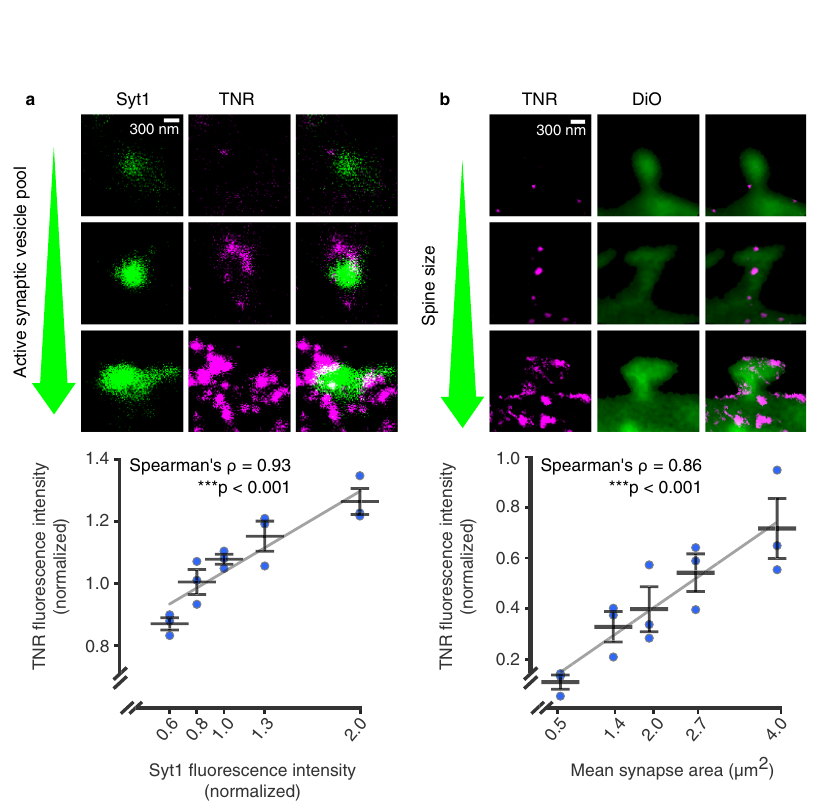
Fig. 2 Dynamic TNR molecules emerge at synapses, in an activity-dependent fashion. a To monitor dynamic TNR molecules, surface epitopes were blocked by incubating with non- fl uorescent TNR antibodies (gray). After some time, fl uorophore-conjugated antibodies were applied (red) to reveal newly- emerged epitopes (dark blue). b Newly-emerged epitopes 2/4/12 h post-blocking, (epi fl uorescence). Scale bar = 10 µ m. c Fluorescence intensity, normalized to non-blocked neurons. N = 3 independent experiments, ≥ 10 neurons per datapoint. Repeated-measures one-way ANOVA: F 1.089,2.179 = 790.8, *** p < 0.001, followed by Fisher ’ s LSD: ‘ 2 h ’ / ‘ 4 h ’ : *p = 0.041; ‘ 4 h ’ / ‘ 12 h ’ : *p = 0.032; ’ 12 h ’ / ‘ no blocking ’ : ** p = 0.002. d All TNR epitopes (left) or newly-emerged epitopes 12 h post-blocking (right) were revealed (magenta, STED imaging). Membranes of a subset of neurons were labeled using sparse DiO labeling (green, confocal imaging). Presynapses were identi fi ed by VGlut1 (blue, STED imaging). Scale bars: 1 µ m (full images), 500 nm (insets). Bottom: hundreds of synapses were averaged by centering synapse images on the VGlut1 puncta and orienting the dendritic DiO signals vertically. “ All ” TNR epitopes cover the entire bouton-dendrite area (left), while newly-emerged epitopes are enriched in the bouton region (right). e Quanti fi cation of TNR exchange at synapses (as in c , measuring exclusively TNR at VGlut1-labeled synapses). N = 3 independent experiments with >100 synapses. f Comparison of newly-emerged TNR epitopes 12 h post-blocking in cultures treated with bicuculline (40 µ M), or CNQX (10 µ M) and AP5 (50 µ M). Intensity is normalized to the corresponding control (DMSO). N = 3 experiments, ≥ 10 neurons per datapoint. One-way ANOVA on rank: F 2,6 = 42, *** p < 0.001, followed by Dunn ’ s multiple comparisons test: ‘ ctrl ’ / ‘ CNQX + AP5 ’ : ** p = 0.003; ‘ ctrl ’ / ‘ bic ’ : * p = 0.042. Data represent the mean ± SEM, dots indicate individual experiments. g , Analysis of 2-color-STED images (as shown in d ). Synaptic enrichment is substantially higher for newly-emerged epitopes. N = 3 independent experiments with >100 synapses. Repeated-measures one-way ANOVA on log-transformed data: F 1.977,3.954 = 24.13, ** p = 0.006, followed by Fisher ’ s LSD: ‘ new ’ / ‘ all ’ epitopes: *p = 0.024 (dendrites); * p = 0.036 (axons). Data represent the mean (line) ± SEM (shaded region). Source data are provided in Source Data fi le.